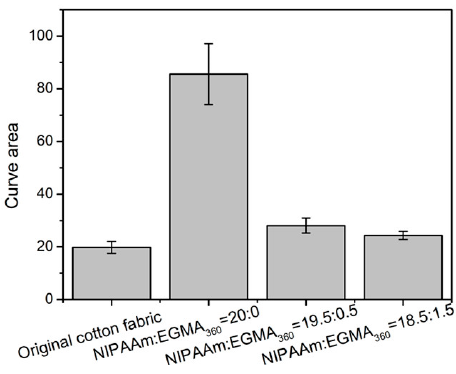
Figure 14. Curve areas of the cotton fabric grafted with alginate-Ca 2+ /P(NIPAAm- co -EGMA 360 ) hydrogels. The monomer ratios of NIPAAm to EGMA 360 are 20:0 19.5:0.5, and 18.5:1.5.